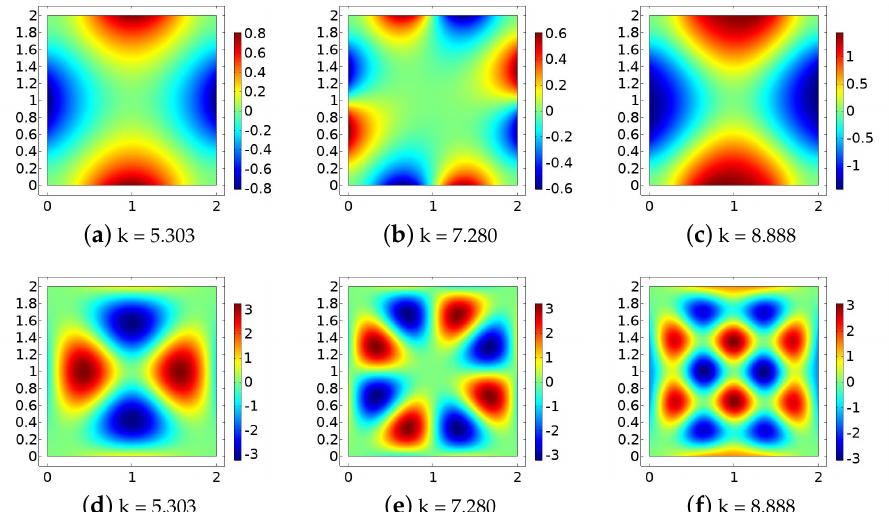
Figure 6. The magnitude of transmission eigenfunctions for a square with different k ’s. ( a – c ): eigen- functions w ’s; ( d – f ): eigenfunctions v